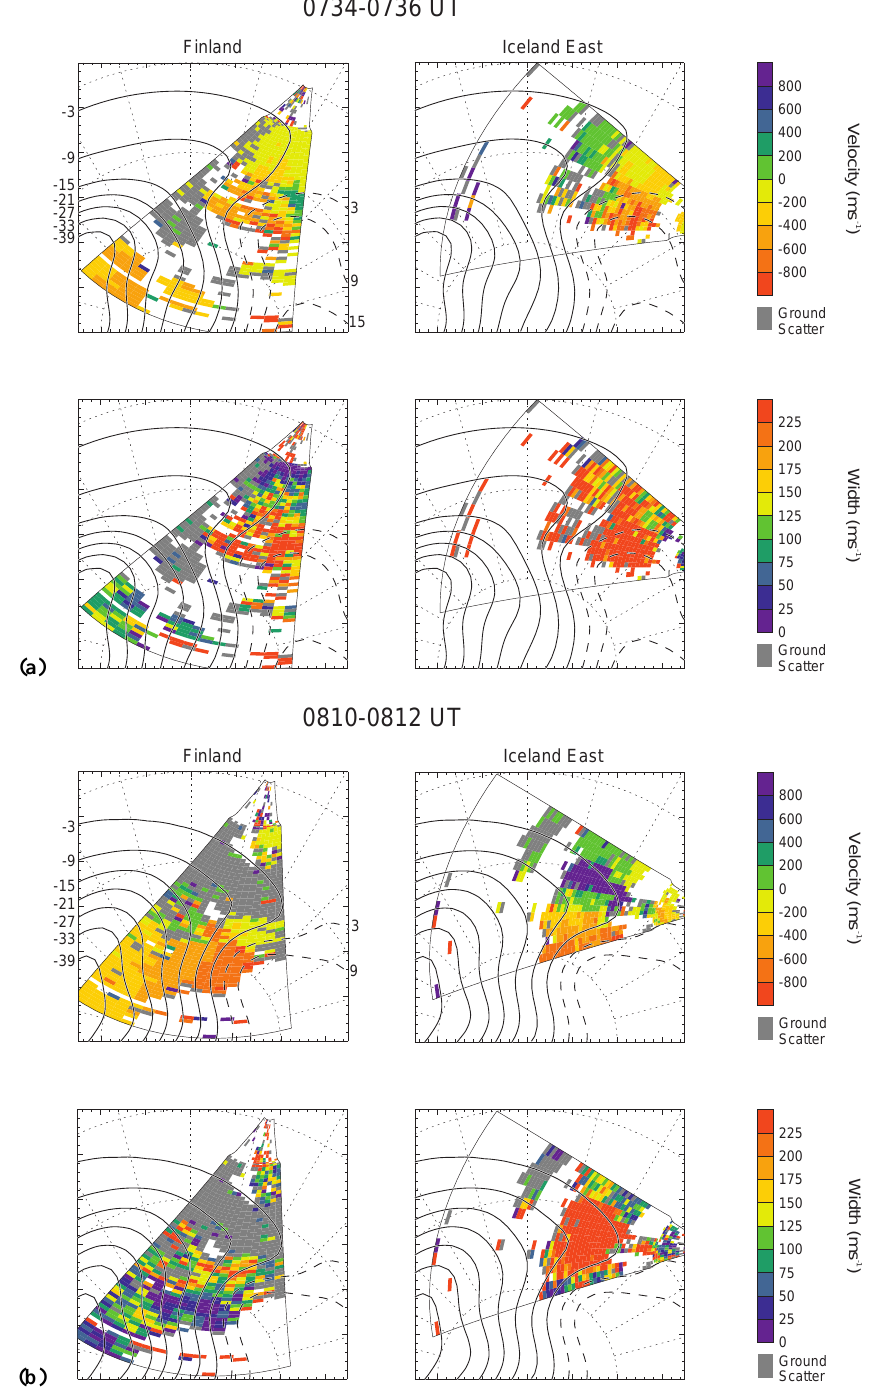
Fig. 5. (a) The left- and right-hand panels of this figure illustrate spatial maps of line-of-sight irregularity drift velocity (upper panel) and spectral width (lower panel) from the CUTLASS Finland and Iceland East radars, respectively, for the scan starting at 07:34UT. Maps are plotted in magnetic latitude and magnetic local time (MLT) coordinates; radial dotted lines indicate MLT meridians, with 12MLT vertically upwards, while concentric dotted circles represent magnetic latitudes of 60, 70 and 80 ◦ . Positive drift velocities are those directed towards the radar. Overlaid on each panel are contours of the electrostatic potential, derived using the technique developed by Ruohoniemi and Baker (1998) as discussed in the text, with solid and dashed lines indicating negative and positive potentials, respectively. (b) As for Fig. (a), for the scan starting at